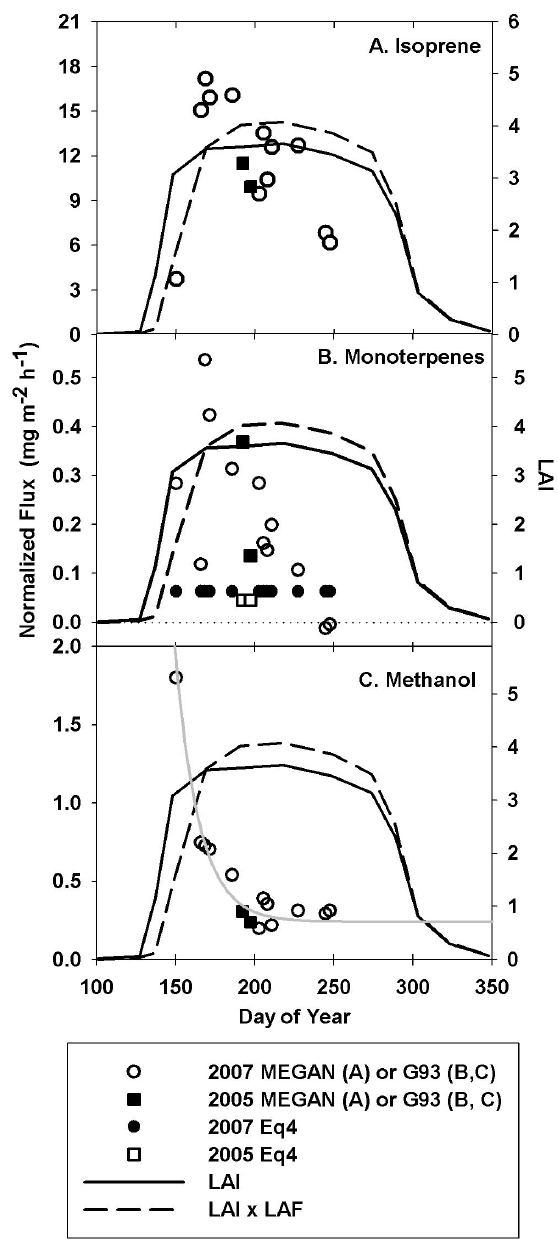
Fig. 8. Normalized emission rates for isoprene (A) , monoterpenes (B) , and methanol (C) over the course of the 2007 growing season. Also shown are the leaf area index and the product of the leaf area index and the leaf age factor (LAF). An exponential fit with a time constant of 15 days is also shown for methanol (grey